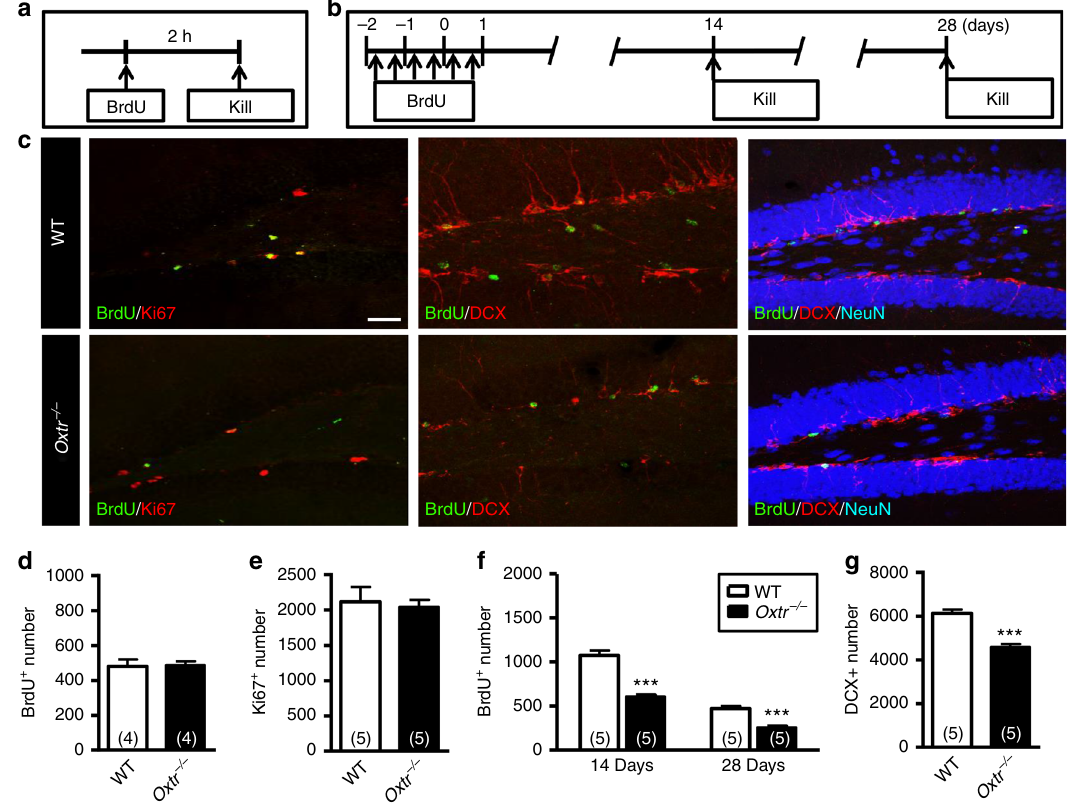
Fig. 3 Conditional deletion of Oxtr impairs the survival of newly generated DGCs. a Schematic representation of the experimental designs for comparing the proliferation of newly generated DGCs in WT and Oxtr − / − mice. Mice were given a single injection of BrdU (50 mg/kg) and were killed 2 h after BrdU injection. b Schematic representation of the experimental designs for comparing the survival of newly generated DGCs in WT and Oxtr − / − mice. Mice were injected six times intraperitoneally with BrdU (50 mg/kg) at 12 h intervals and were killed 14 and 28 days after the last BrdU injection. c Representative immuno fl uorescence images of hippocampal sections from WT and Oxtr − / − mice double or triple stained for BrdU ( green ), Ki67 ( red ), DCX ( red ), and NeuN ( blue ) after BrdU injection. Scale bar , 100 µ m. d Quanti fi cation of the total number of BrdU + cells in the DG of WT and Oxtr − / − mice at 2 h after BrdU injection ( n = 4 mice per genotype, unpaired two-tailed Student ’ s t test). e Quanti fi cation of the total number of Ki67 + cells in the DG of WT and Oxtr − / − mice at 2 h after BrdU injection ( n = 5 mice per genotype, unpaired two-tailed Student ’ s t test). f Quanti fi cation of the total number of BrdU + cells in the DG of WT and Oxtr − / − mice at 14 and 28 days after BrdU injection ( n = 5 mice for each group; *** P < 0.001, unpaired two-tailed Student ’ s t test). g Quanti fi cation of the total number of DCX + cells in the DG of WT and Oxtr − / − mice at 14 days after the last BrdU injection ( n = 5 mice per genotype; *** P < 0.001, unpaired two-tailed Student ’ s t test). Data represent the mean ±